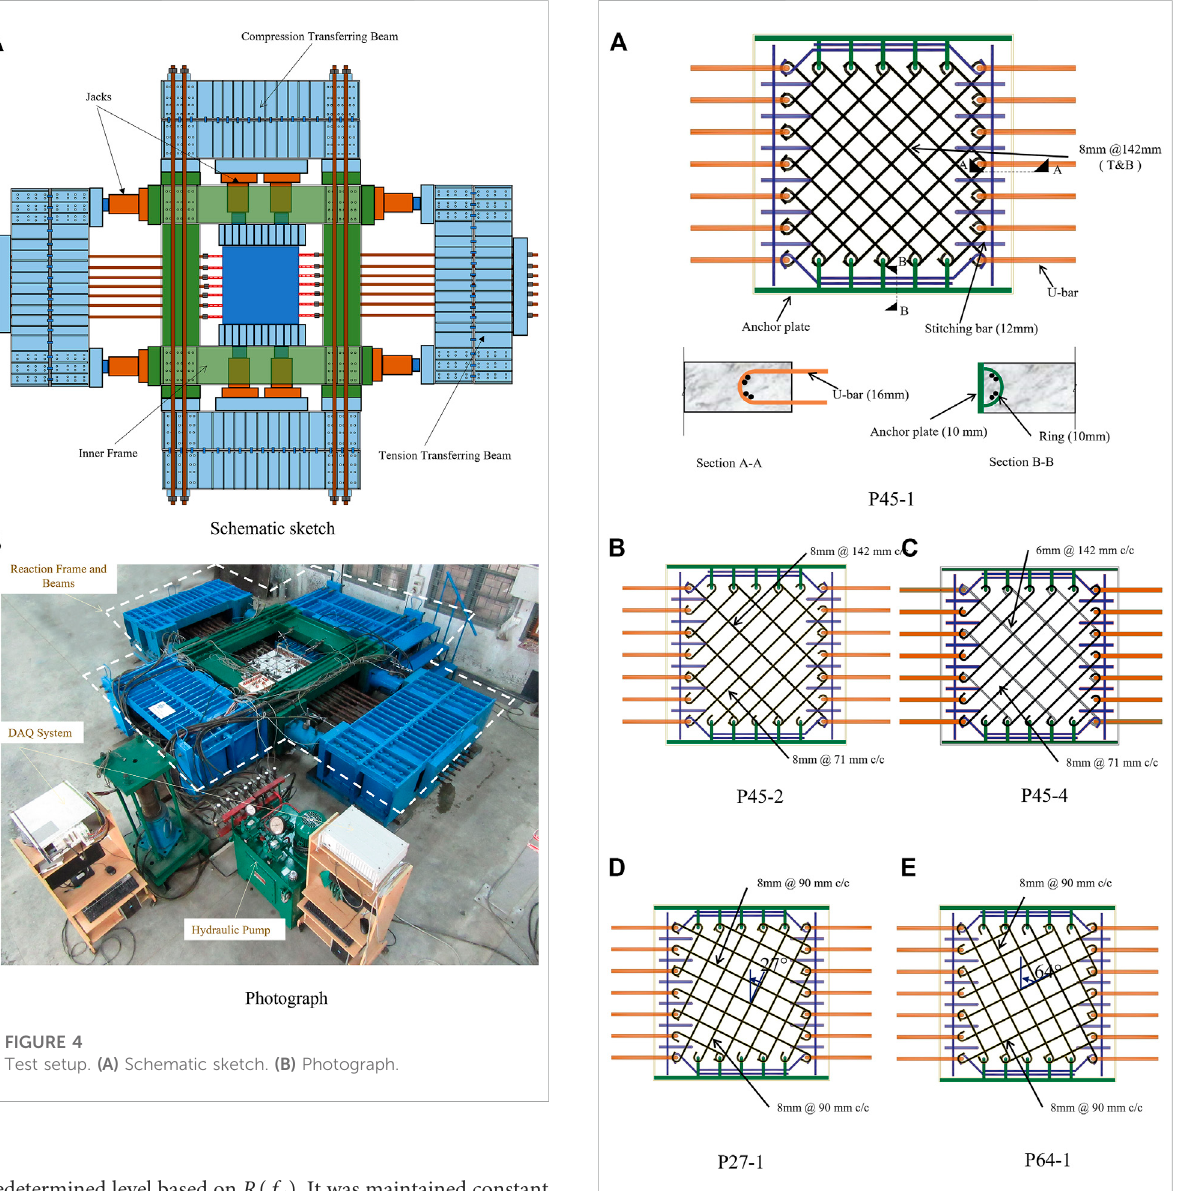
FIGURE 5 Reinforcement details of panel series. (A) P45-1 (B) P45-2